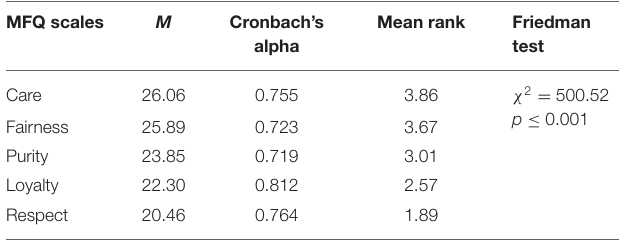
TABLE 1 | Comparative analysis of the moral norms dominance among Russians during the COVID-19 pandemic (MFQ). MFQ scales M Cronbach’s Mean rank Friedman alpha test